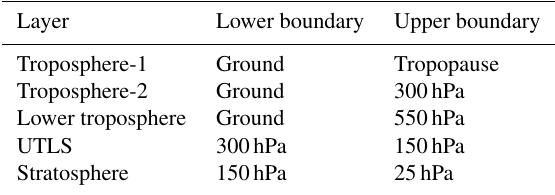
Table 1. Atmospheric layers for